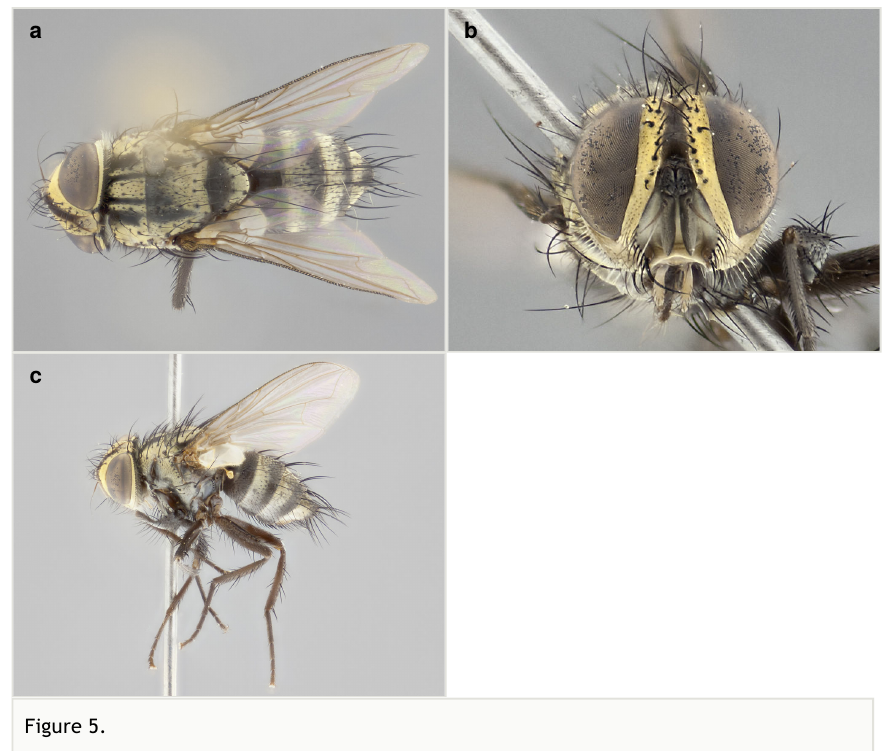
Figure 5. Vibrissina hallwachsorum sp. n. a–c : holotype female, voucher code: DHJPAR0017884. a : habitus in dorsal view b : head in frontal view c : habitus in lateral